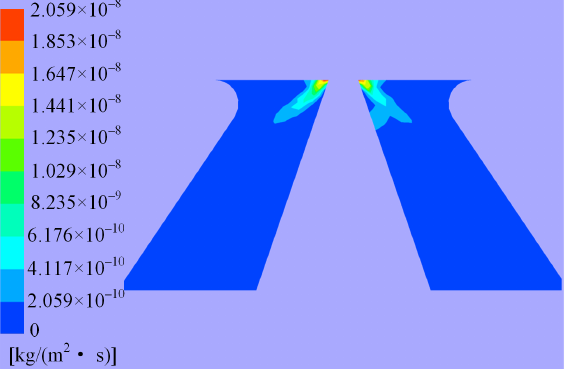
Figure 9. Erosion rates of lower surface of the